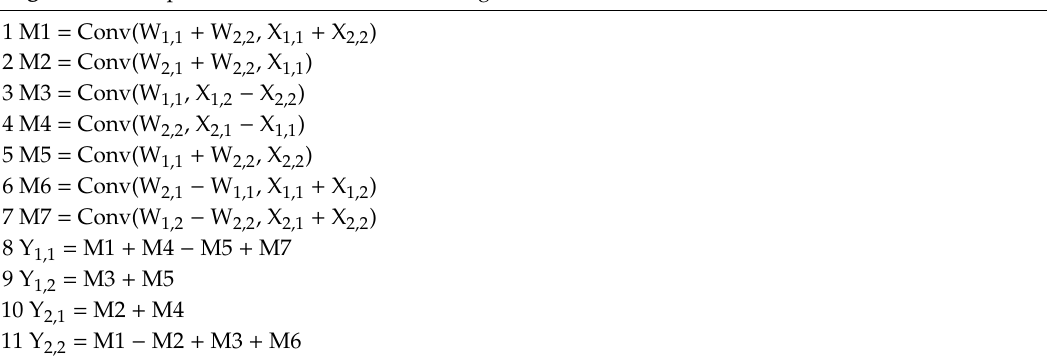
Algorithm 1. Implementation of the Strassen